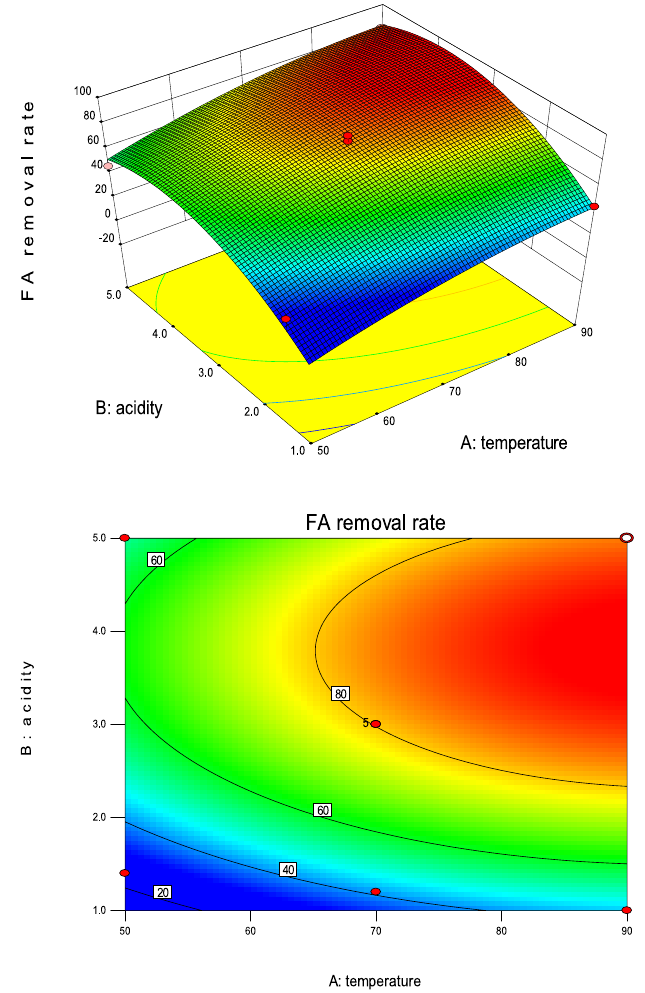
Figure 3. 3D response surface graph and contour plot.